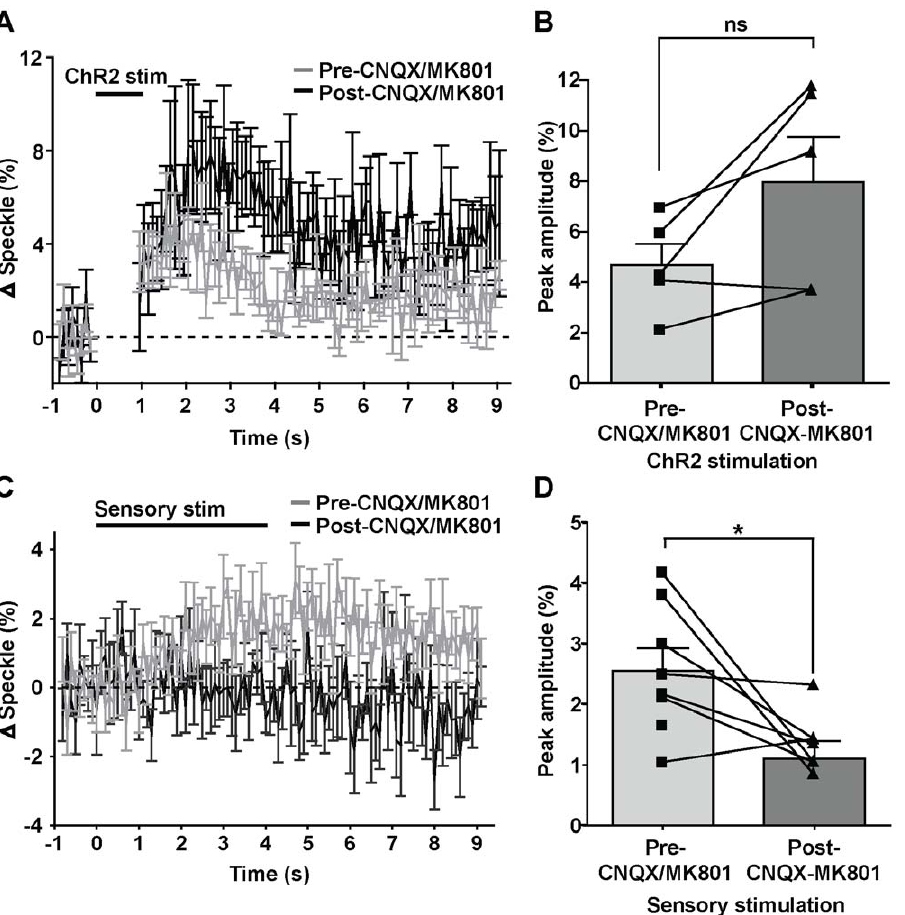
Figure 4. ChR2-evoked blood flow is not inhibited by blocking intracortical ionotropic glutamatergic synaptic transmission by CNQX/MK801. A, Temporal profiles of laser speckle responses evoked by 1 s of ChR2 stimulation before and after antagonist incubation. B, Comparison of peak amplitudes (averaged over 1 s) in laser speckle contrast responses in (A) before and after antagonist incubation. No significant difference was observed (n=5, paired t-test, p=0.0789). C, Temporal profiles of laser speckle responses evoked by forepaw sensory stimulation before and after antagonist incubation. D, Comparison of peak amplitudes (averaged over 1 s) in laser speckle contrast responses in (C) before and after antagonist incubation. A significant difference was observed (n=8, paired t-test, p=0.0144). Error bars represent